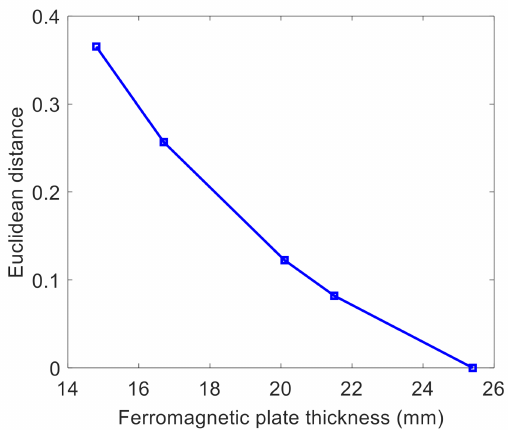
Figure 3. Euclidean distances under different plate thicknesses from analytical